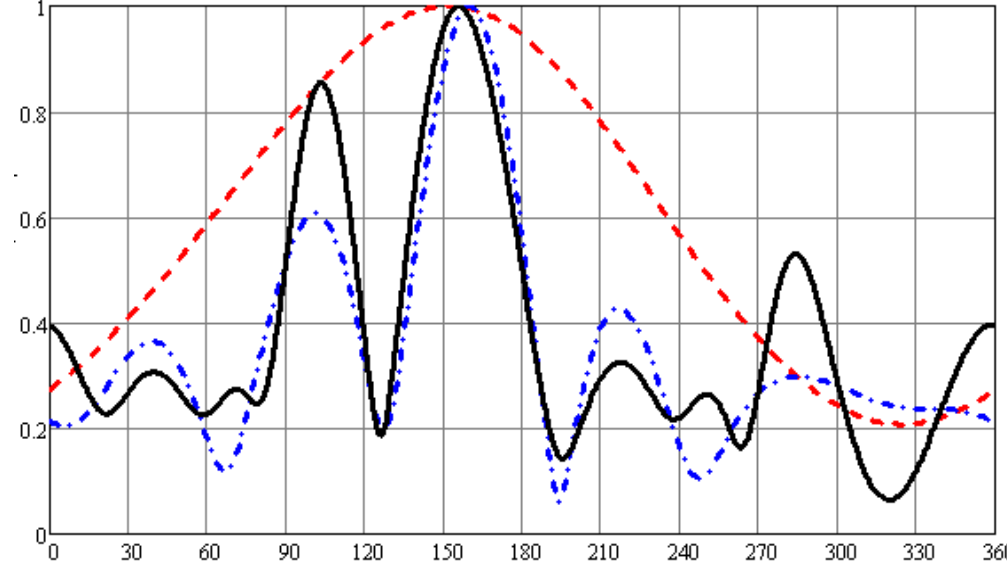
Figure 21. Azimuths of the sources— α 1 = 100 ◦ and α 2 = 160 ◦ ; VAA radius is 1.9 m; N = 72.